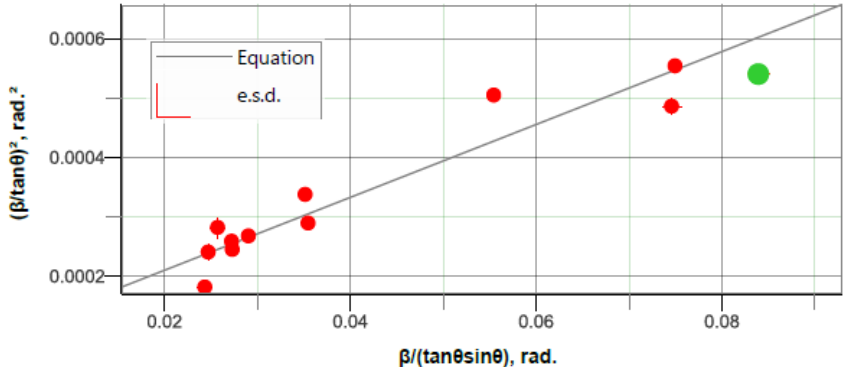
Figure 4. Graph for crystallite size determination of the powder-alloy sample.